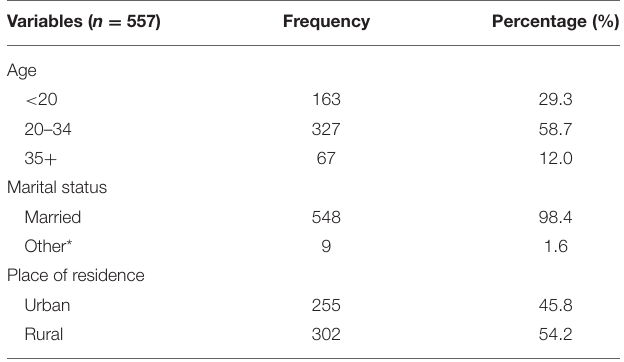
TABLE 1 | Sociodemographic characteristics of study participants ( n = 557), Hiwot Fana Specialized University Hospital, Harar, Eastern Ethiopia, 2018/2019.